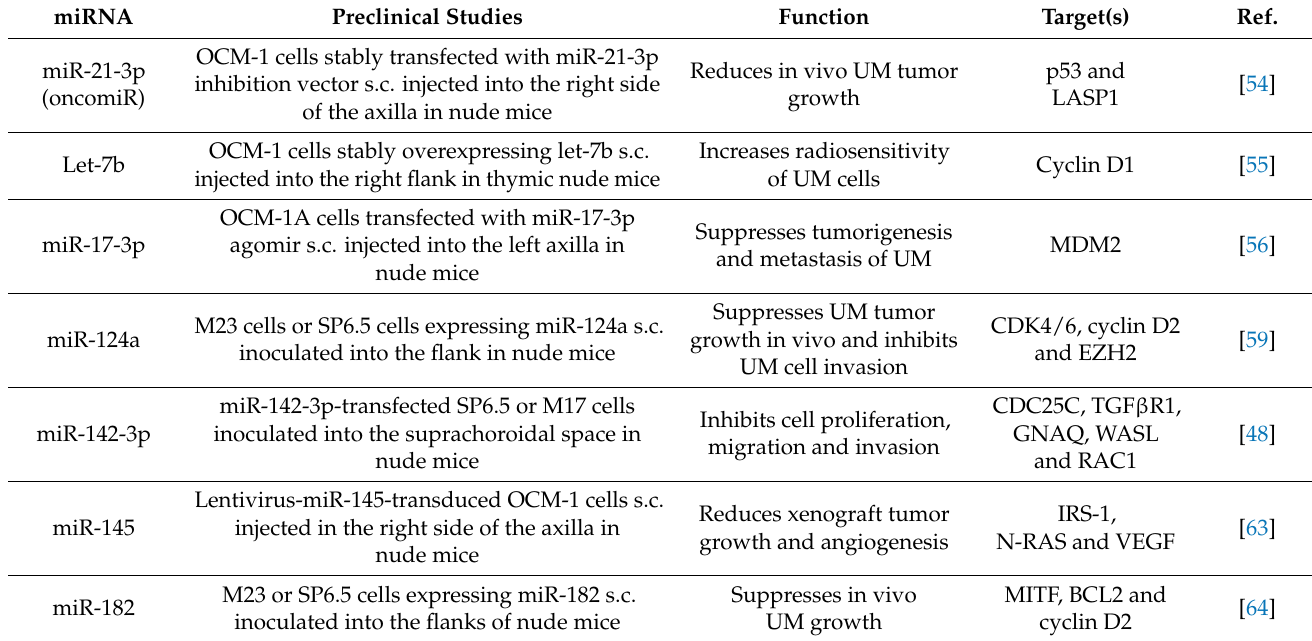
Table 1. List of miRNAs with therapeutic potential for UM, identified in preclinical